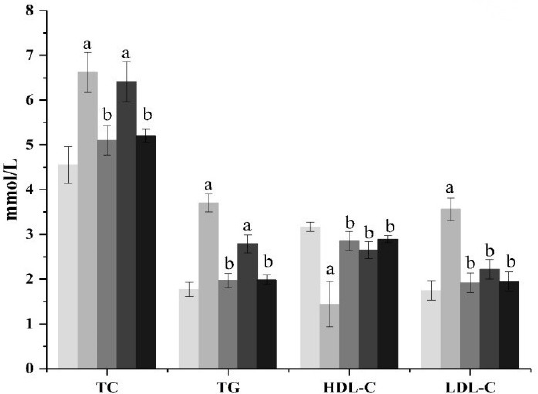
Figure 1. Effect of ACP on serum lipids indexes in mice. Mean values ± SD (n = 6.) a: Compared with the normal group, p < 0.01; b: Compared with the model group, p < 0.01. 1: normal, 2: model, 3: positive control, 4: ACP low dose, 5: ACP high dose.